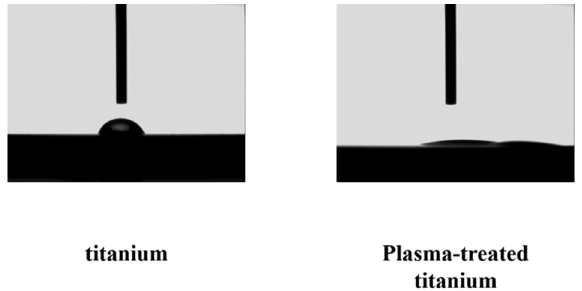
Figure 4. Contact angle of titanium and plasma-modified titanium. There was a clear difference between the contact angles (titanium; 32°, plasma-modified titanium; 0°) of the plasma-treated titanium disks and those of the titanium disks (Figure 4).